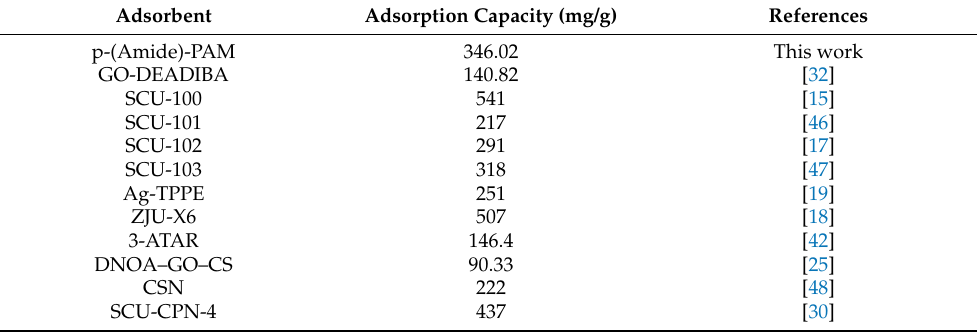
Table 3. Adsorption capacity of 99 TcO 4 − /ReO 4 − by different adsorption materials. Adsorbent